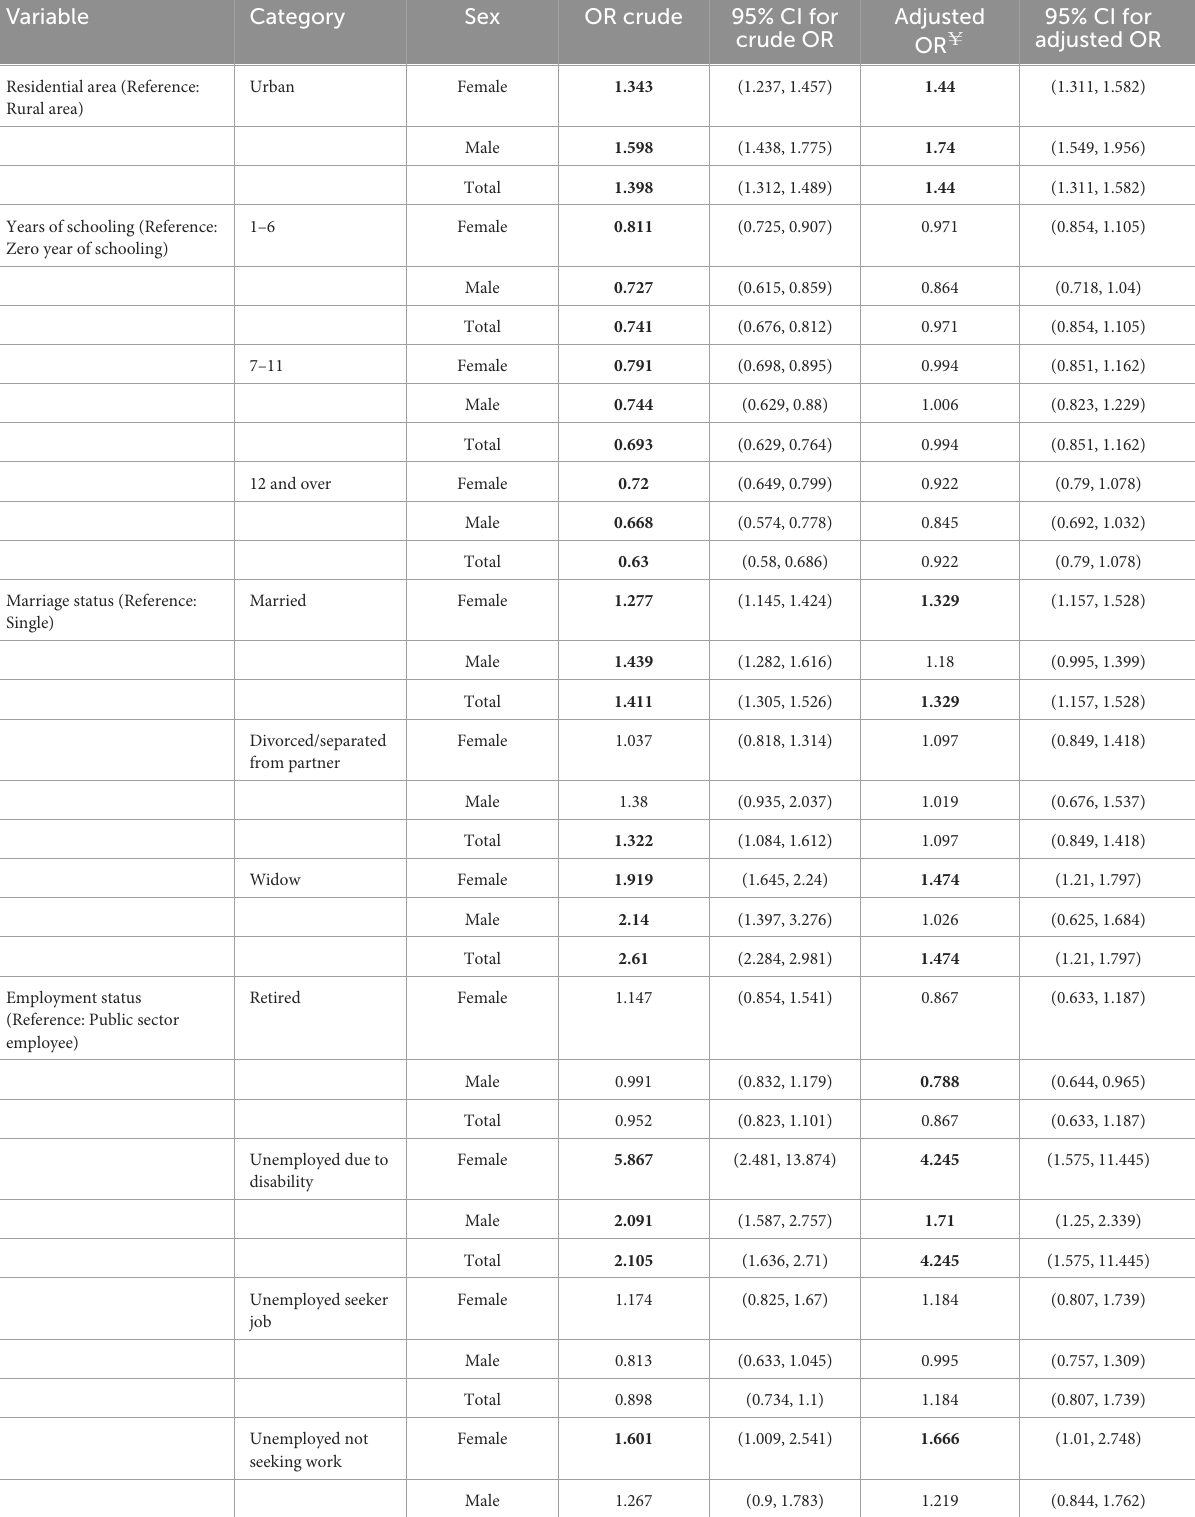
TABLE 4 Associates of insufficient physical activity in Iran. Variable